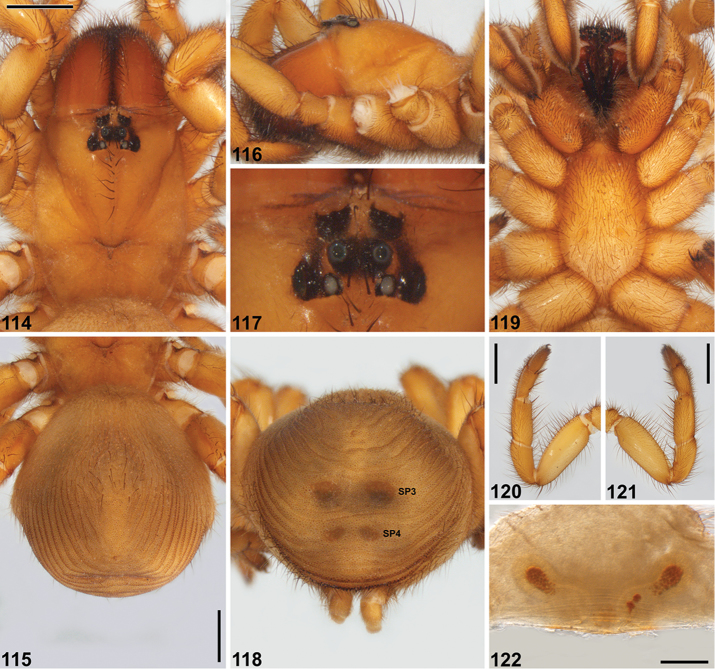

Idiosoma
corrugatum sp. n., female (WAM T144634) from NW. of Cleve (South Australia; EYB). 114–115 Carapace and abdomen, dorsal view 116 Carapace, lateral view 117 Eyes, dorsal view 118 Abdomen, posterior view 119 Sternum, ventral view 120 Leg I, prolateral view 121 Leg I, retrolateral view 122 Spermathecae, dorsal view. Scale bars 2.0 (114–115, 120–121), 0.5 (122). SP3–4 = sigilla pairs 3–4.